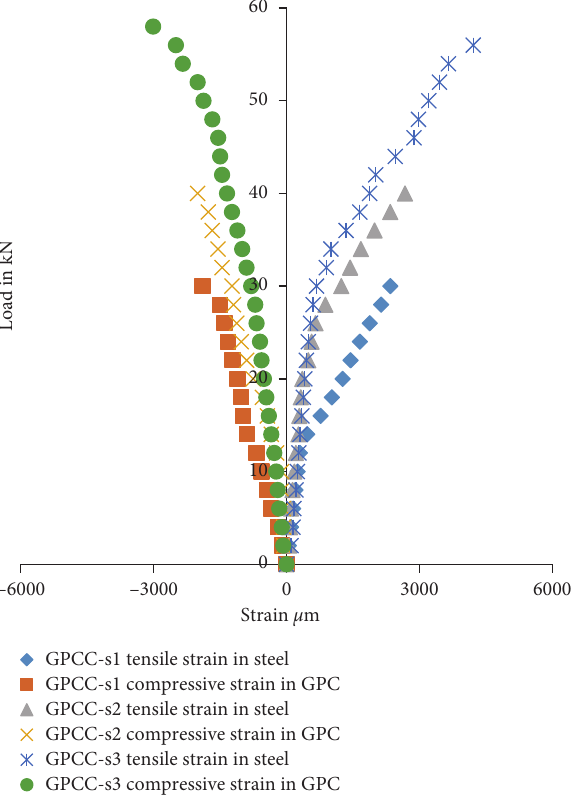
Figure 16: Load-strain behaviour of GPCC (SRB).